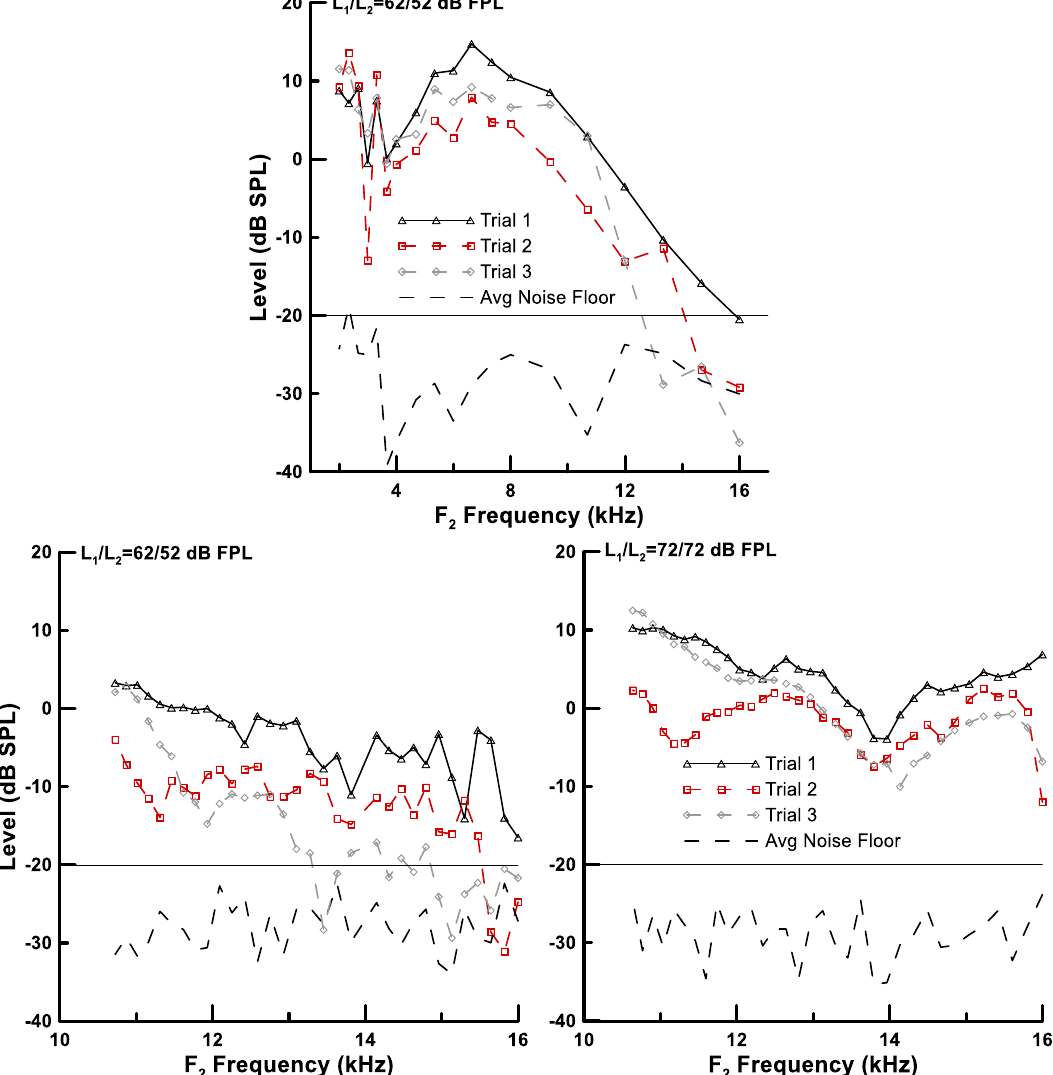
Figure 1. Gross and concentrated frequency sweep results for patient 9. The top panel represents the results from the gross discrete frequency sweep (L 1 / L 2 = 62 / 52 dB forward pressure level (FPL)), while the bottom left panel illustrates the results from the high-level concentrated frequency sweep (L 1 = L 2 = 72 dB FPL), and the bottom right panel depicts the data collected for the mid-level concentrated frequency sweeps (L 1 / L 2 = 62 / 52 dB FPL). Black triangles, red squares, and grey diamonds indicate sessions 1, 2, and 3, respectively. The thin dashed black line indicates the average noise floor for all three sessions. Note, sessions and trials are synonymous.